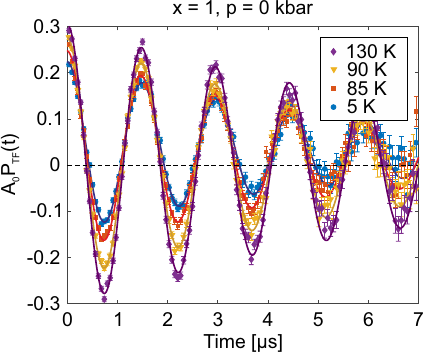
Figure 5. Transverse field (TF = 50 Oe) µ + SR time spectra collected for CaCo 2 P 2 ( x = 1 ) at p = 0 kbar for selected temperatures. The solid lines represents fits with Eq. (2).